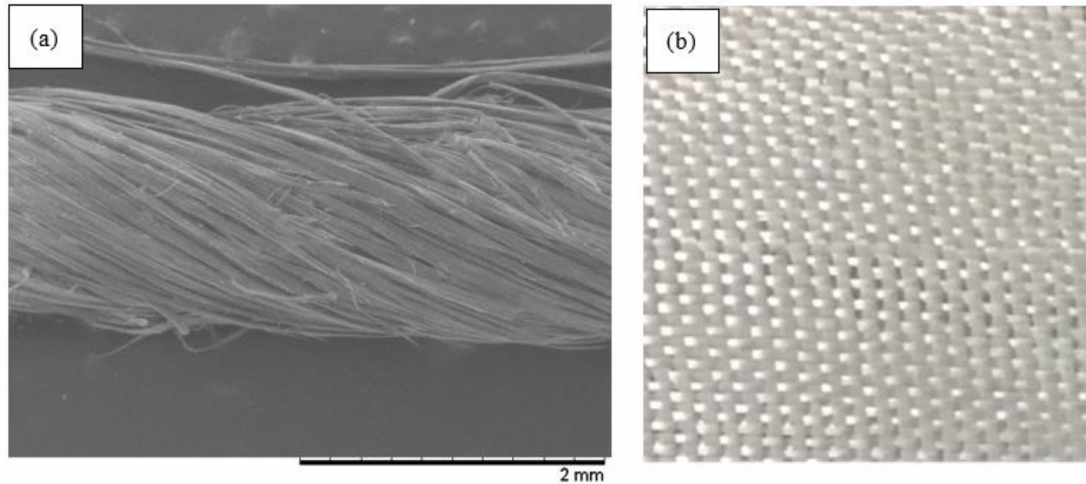
Figure 1. ( a ) Kenaf fiber in yarn form, viewed under scanning electron microscopy (SEM) at magnification of 50 × . ( b ) Glass fiber woven roving